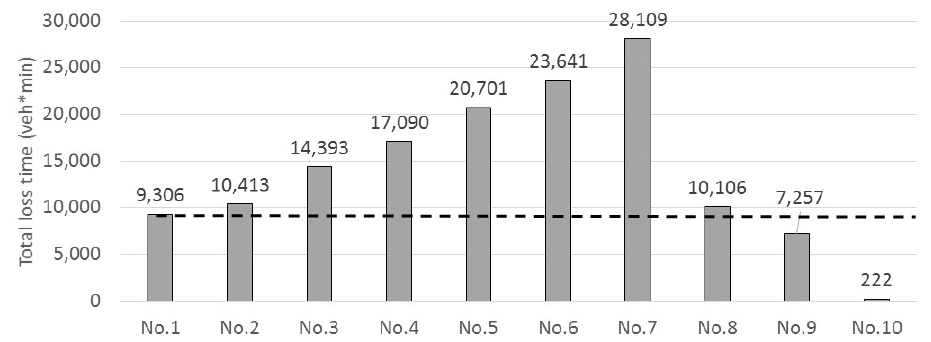
Figure 8. Comparing loss time (no. 1 to no. 10).